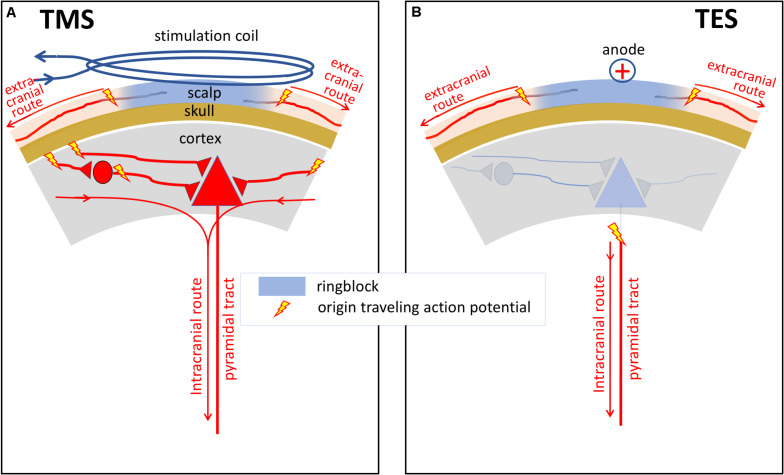
Schematic illustrations of differences between sites of activation and neural processing of neural elements under a TMS coil (A) and under anodal stimulation in TES (B) in human and primates. The major action of TES is to stimulate corticospinal tract axons directly, probably in the subcortical white matter. In contrast, the major action of TMS is the excitation of intracortical axons, which then cause indirect, transynaptic excitation of corticospinal and other corticofugal neurons. The curved lines with arrows show the intra- and extracranial routes of action potentials from the onset of axonal activation. Activation of the extracranial axons occurs outside the ring block.